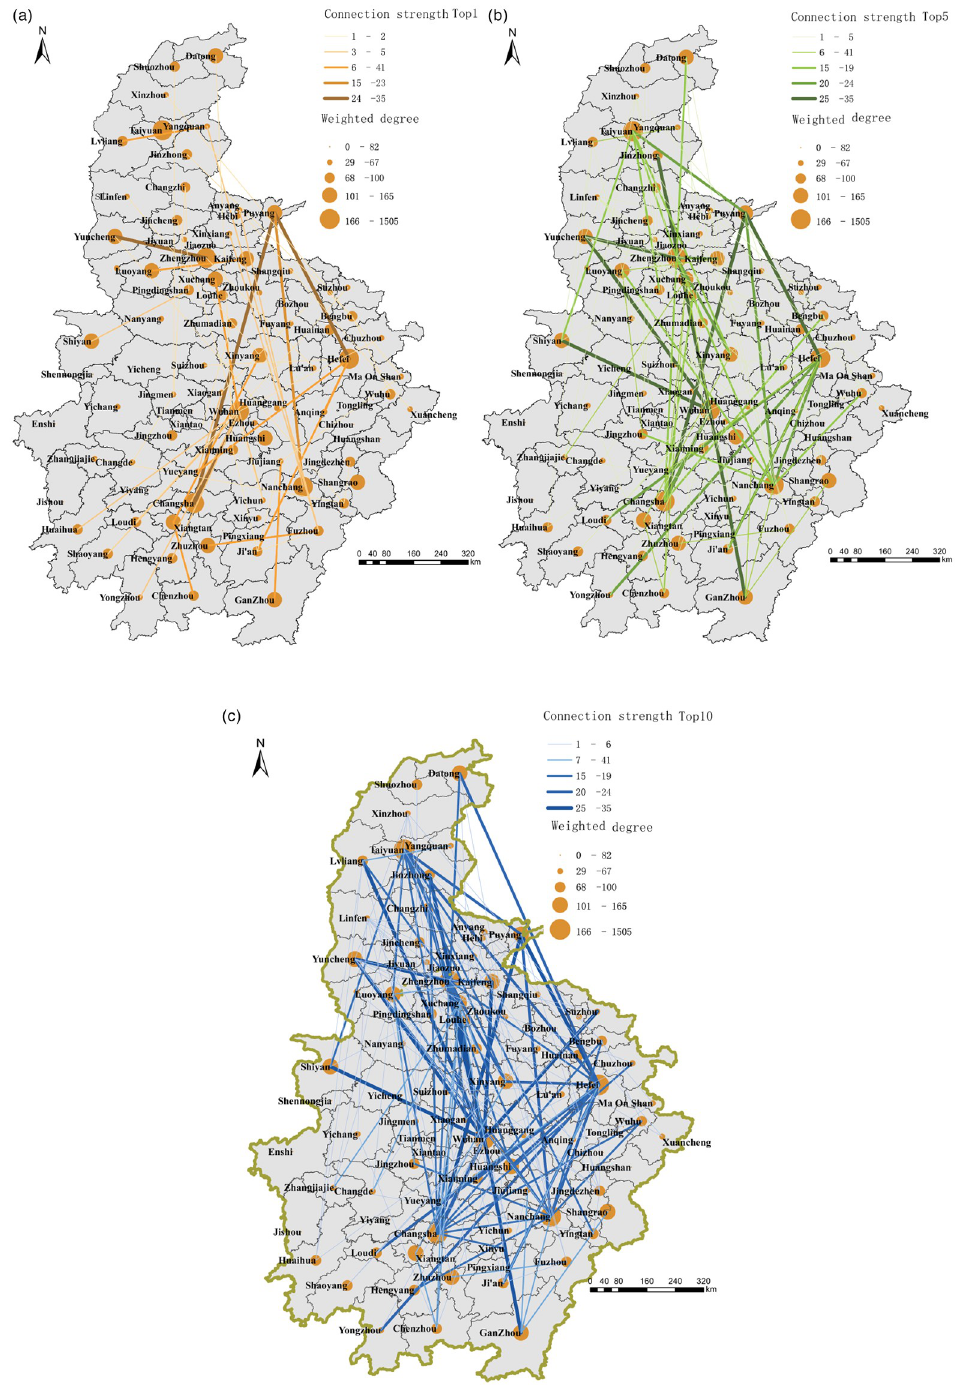
Fig 2. Connection patterns of top 1, 5, and 10 cities in terms of the freight demand impact network in six provinces of central China. a. The first contact map of freight demand. b. The contact map of the top 5 freight demand cities. c. The contact map of the top 10 freight demand